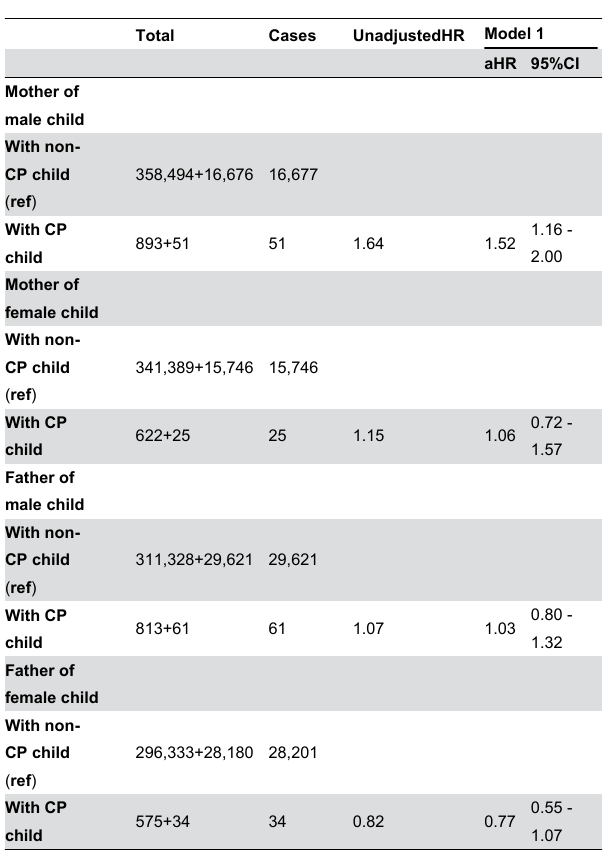
Table 2. Hazard ratio (HR) for cardiovascular disease diagnosis in parents of CP children by gender of the parent and gender of the child.